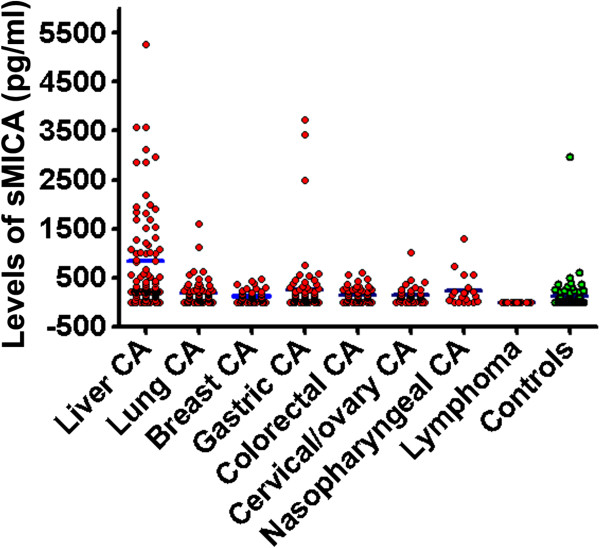
Dot graph showing the distribution and means (blue bars) of serum sMICA concentration (pg/ml) among cancer patients (red) relative to healthy control (green) groups. The liver cancer group shows the highest mean, with the levels of sMICA remarkably elevated among some individuals. Each dot represents an individual case, referring to Table
2 for case numbers in each group and statistics.